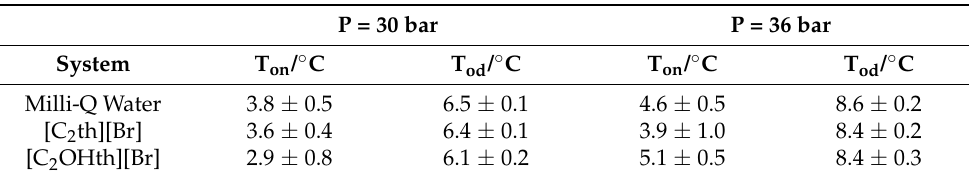
Table 2. Average nucleation (T on ) and dissociation (T od ) onset temperatures for Milli-Q water and 1 wt% aqueous ionic liquids solutions obtained from 12 experiments for each data point along with standard deviations using the constant ramping method.